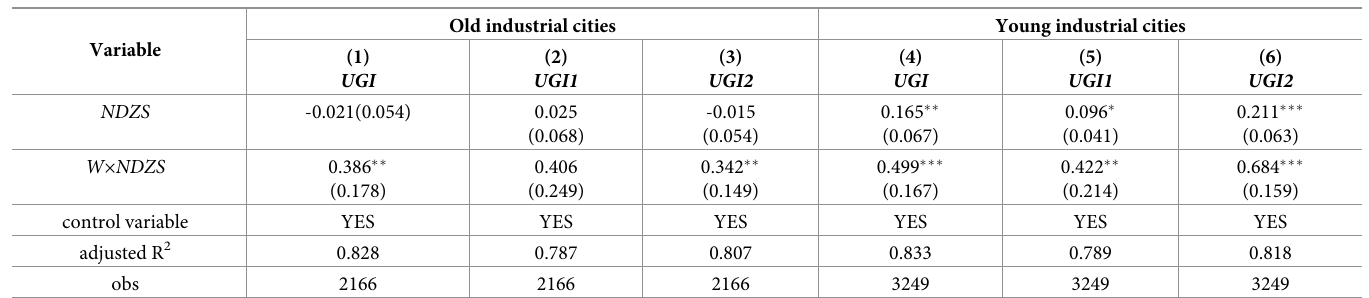
Table 3. Heterogeneity test: Old vs. young industrial cities.